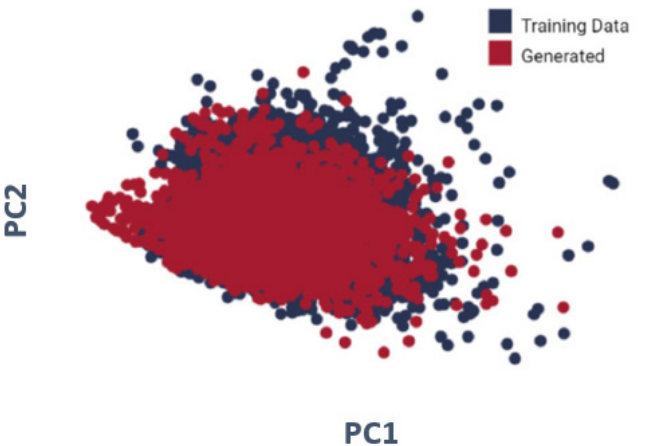
Figure 4. The PCA projection of molecular descriptors from training data as well as molecules created by the LSTM.